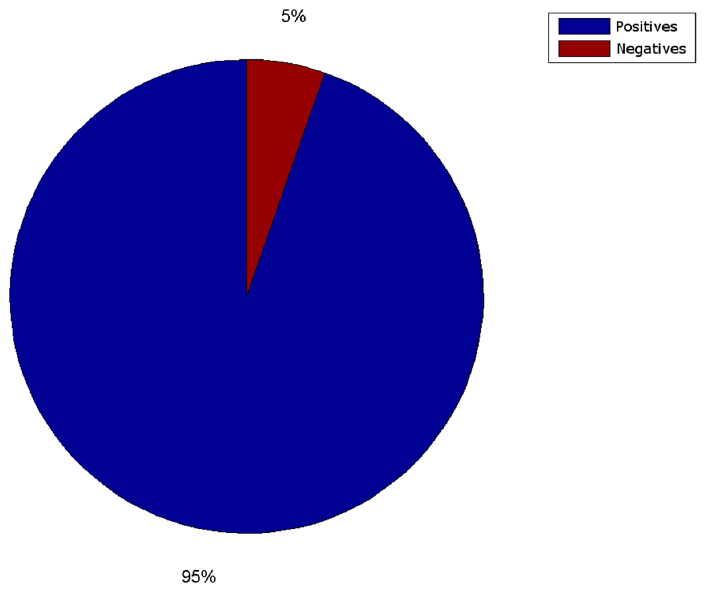
Figure 21. Successful validations are blue (95%). False negative validations are red (5%).